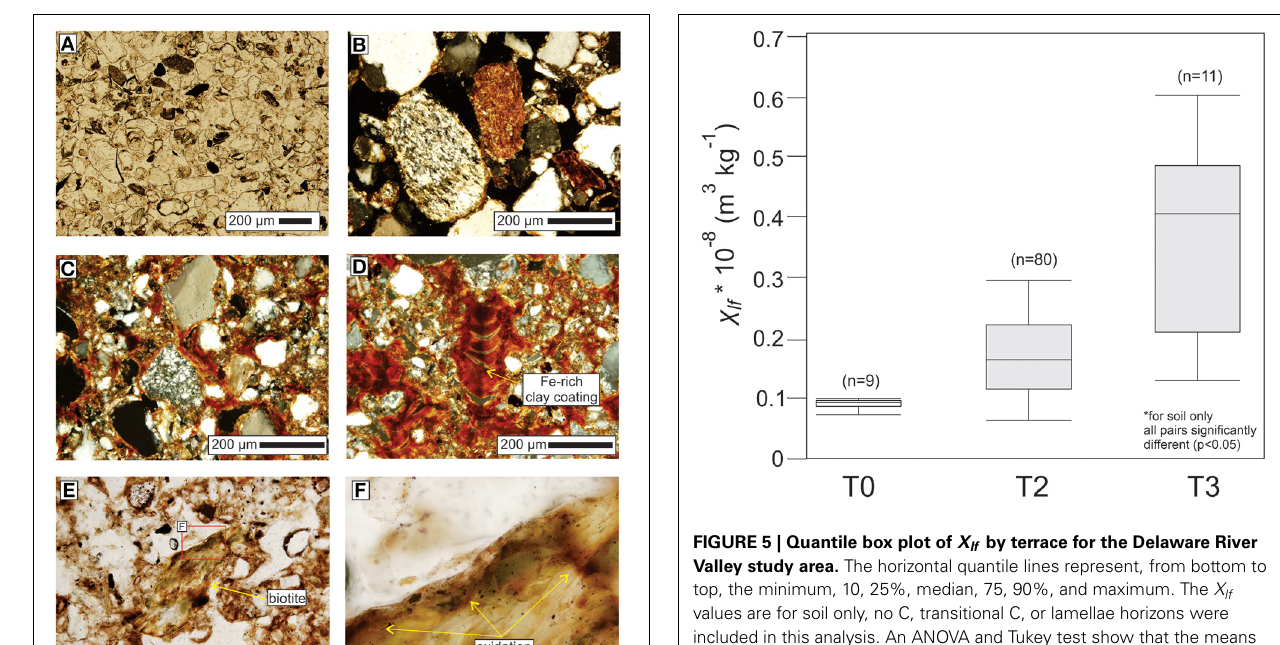
T3, T2, and T0 soils plot within the SD, PSD, and SP-SD